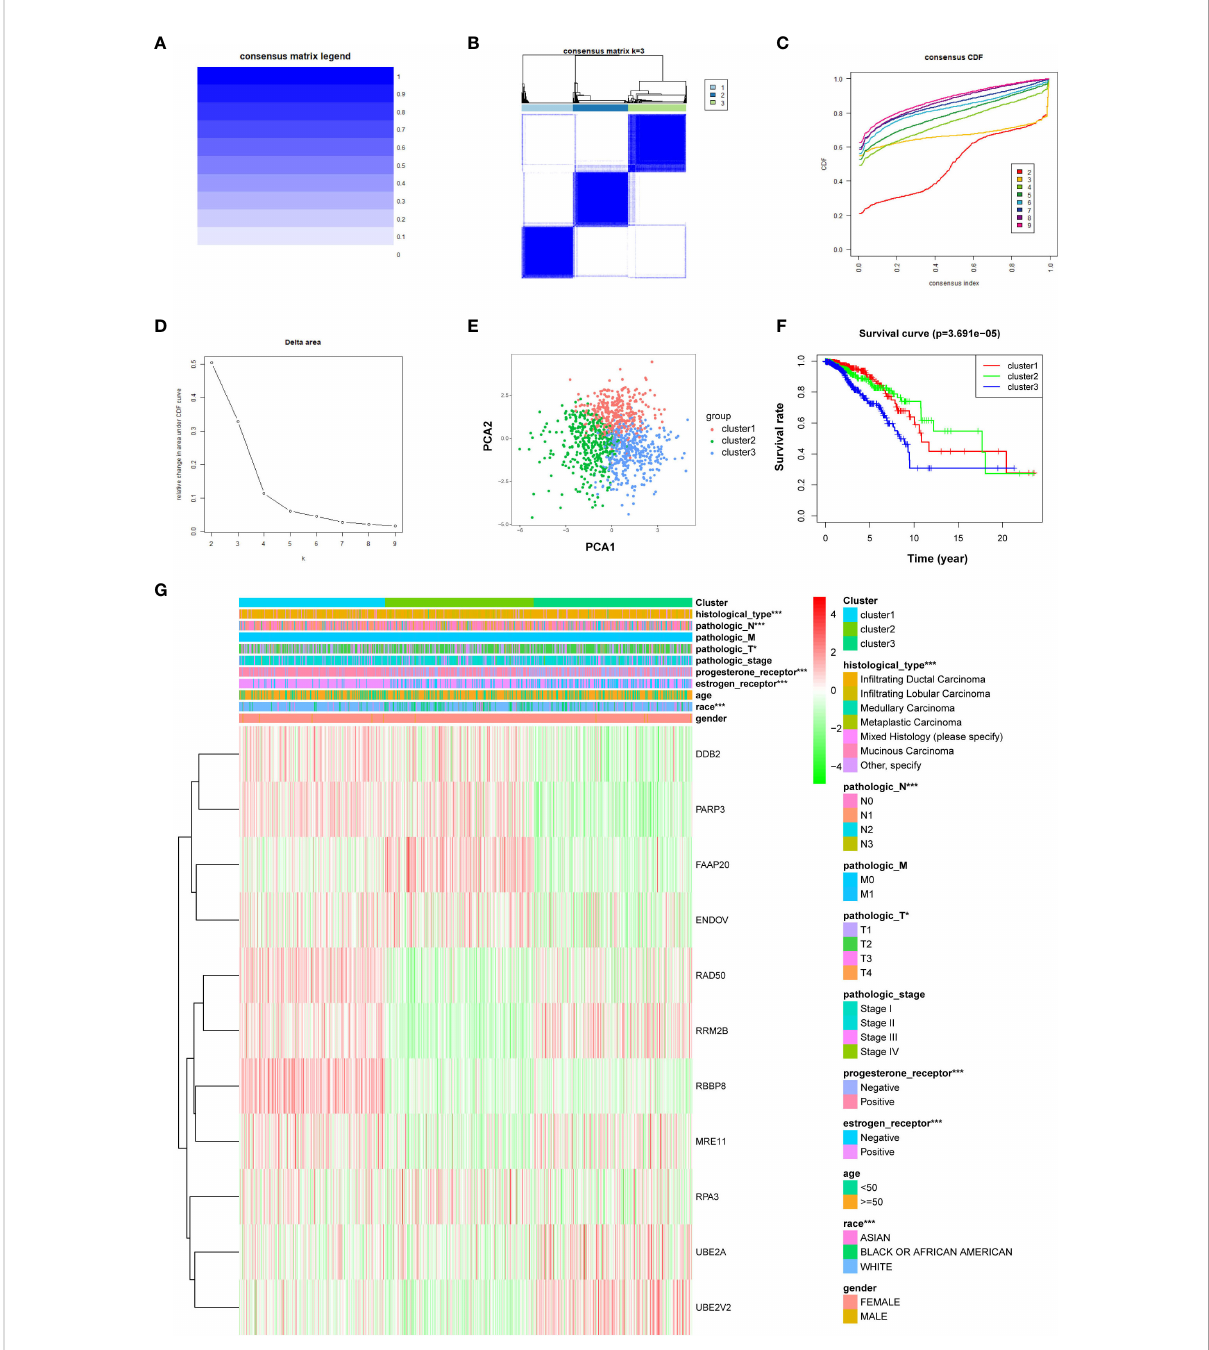
FIGURE 6 The R “ ConsensusClusterPlus ” package is applied to stratify breast cancer samples into three clusters equipped with different prognoses. (A) Consensus matrix legend. (B) Consensus clustering matrix for k = 3. (C) Consensus clustering cumulative distribution function (CDF) for k = 2 – 9. (D) Relative change in AUC of CDF. (E) PCA of the expression pro fi les of DNA repair genes from clusters 1, 2, and 3. (F) Kaplan – Meier curve of OS of patients between clusters 1, 2, and 3. (G) Heatmap of clinical features and three clusters of breast cancer patients. *P < 0.05, ***P <